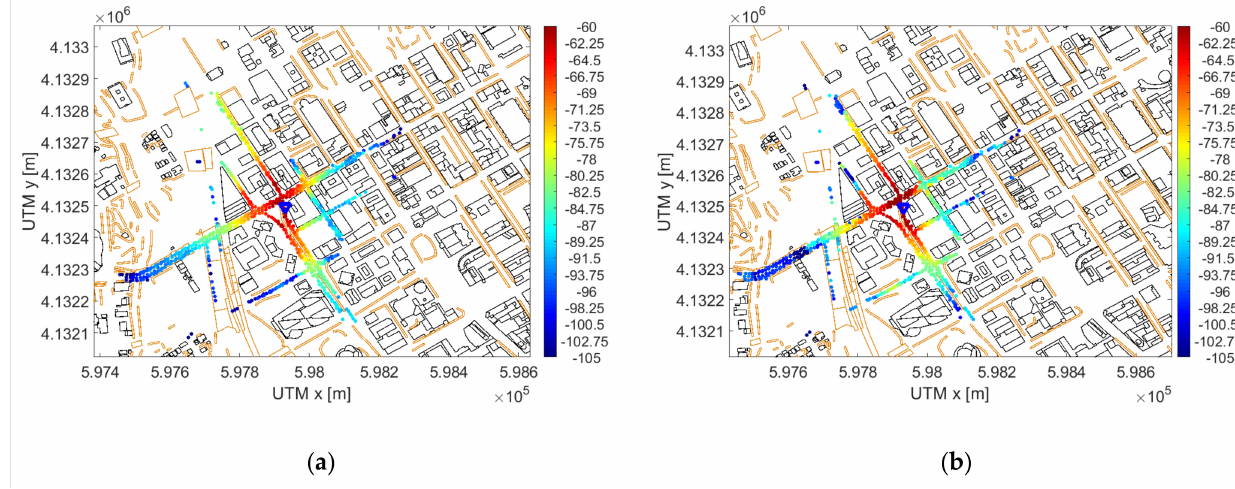
Figure 6. Comparison of ( a ) measurements and ( b ) RL simulations for measurement site n. 40 in San Jos é : in this case σ E = 6.5